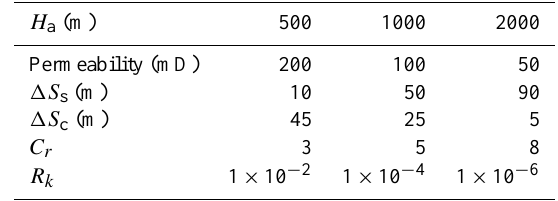
2 Mathematical model